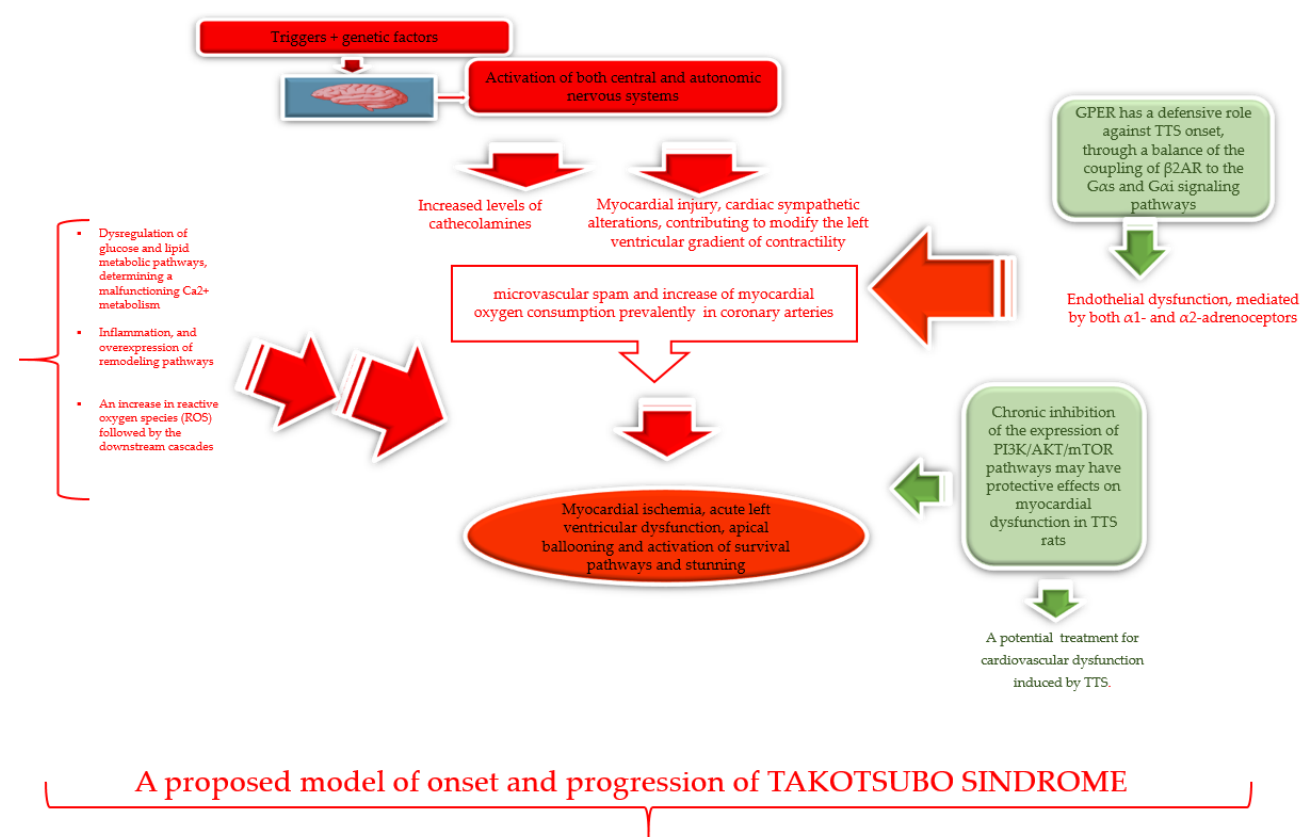
Figure 1. A proposed model of TTS pathophysiology from current evidence: in red the pathways involved, and in green the pathways able to delay or escape the onset and progression of pathological conditions leading to TTS and its related complications.